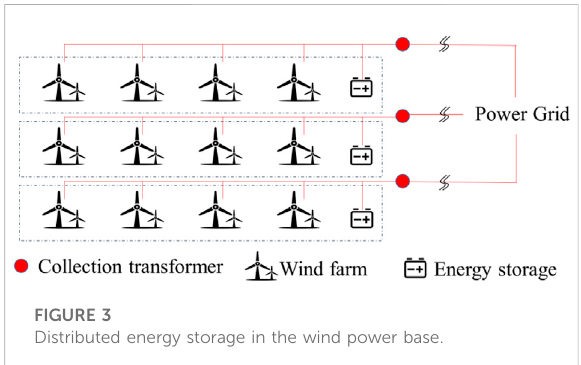
FIGURE 3 Distributed energy storage in the wind power base.